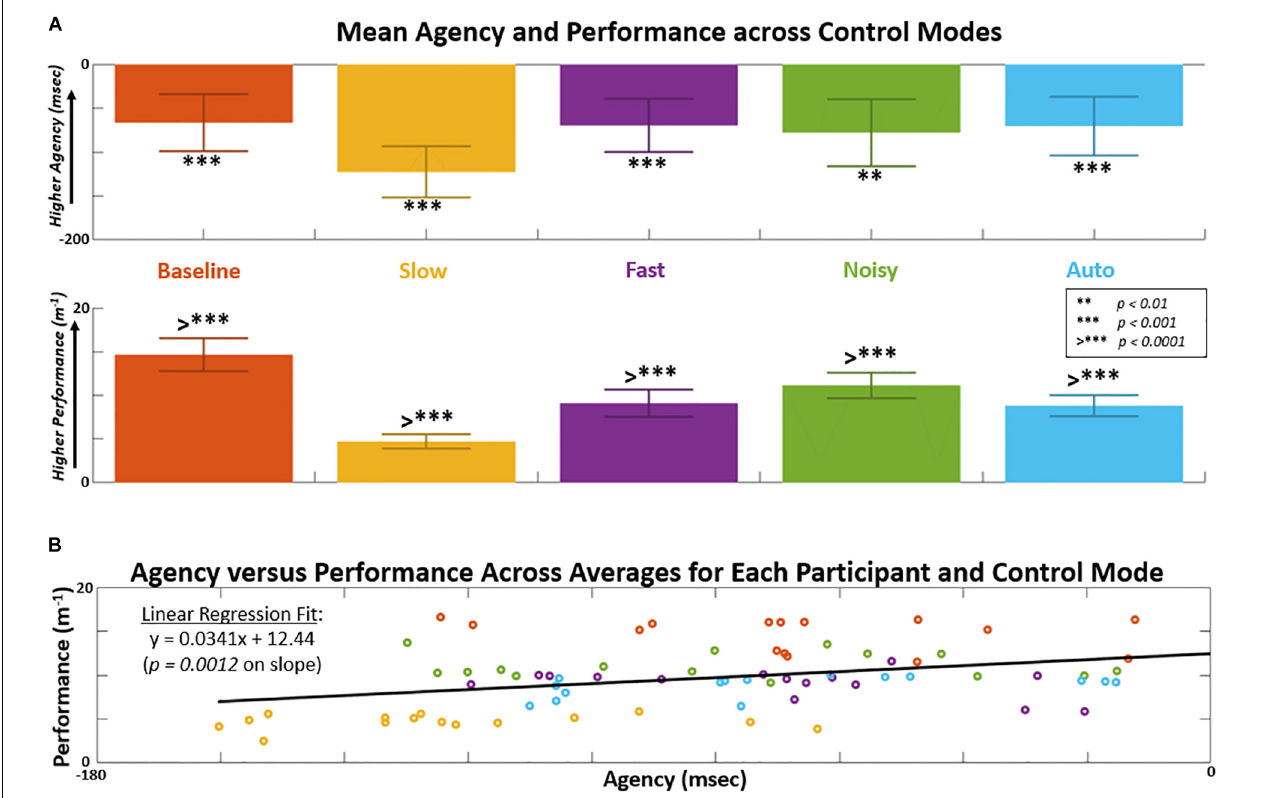
FIGURE 6 | Control mode effects shown for agency and performance. Lowest pairwise p -value < alpha level indicated for each control mode from post hoc comparisons. (A) Agency positively measured according to underestimation of time-interval between grasp action and proceeding sound event. Performance positively measured as inverse of 3-D position error of reaching hand from target minimal path length trajectory. (B) Linear regression applied on data points of mean performance and mean agency across respective subject and control mode. Slope parameter from linear regression indicates a significant (non-zero, p < 0.01) positive relationship between agency and performance. F-stat for regression is 11.43 with p =